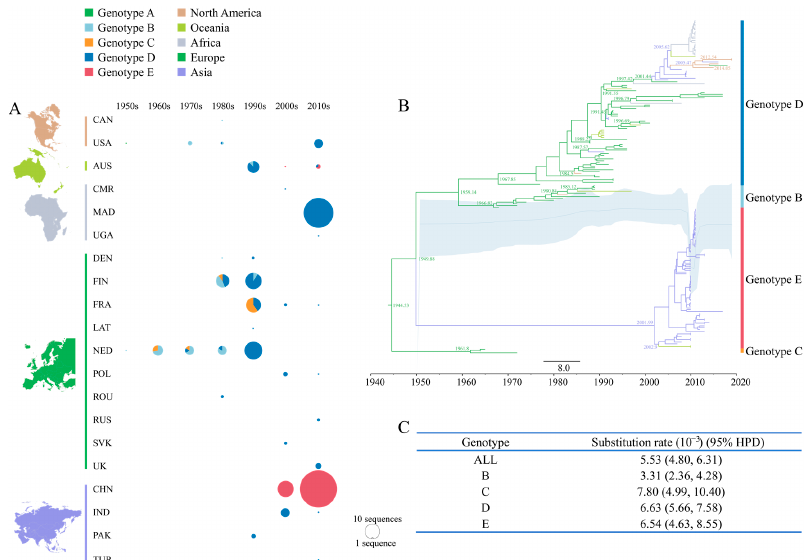
Figure 5. Temporal dynamics analysis of CVB4. ( A ) Geographic and year distribution statistics of 225 CVB4 sequences in this study. The circle size is proportional to the number of sequences (too many CVB4 sequences were isolated in China in the 2010s, the displayed circle size is only one-third of the actual size), and the color of different circles represent different genotypes. ( B ) Maximum clade credibility (MCC) tree based on the VP1 region of 186 CVB4 sequences. The sequence branches are colored according to different continents. ( C ) Statistics of the substitution rate of the VP1 region in different CVB4 genotypes.